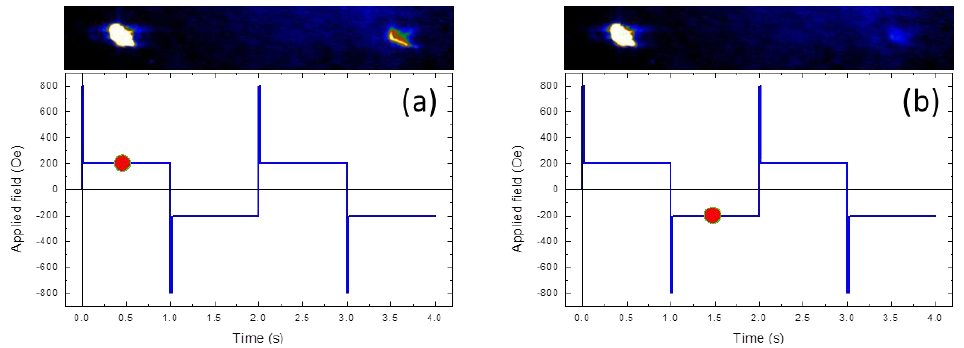
Figure 4. Data acquisition sequence. Sketch of the acquisition sequence used for determining the magnetic signal. ( a ) After a +800 Oe pulse of ~10 ms duration, data are collected in a +200 Oe applied field; ( b ) Same as ( a ), for negative field values. The magnetic signal is defined as the difference divided by the sum of the signals measured for opposite magnetization directions. Top panels: CCD images of the pump (left spot) and probe (right spot) scattered intensities.